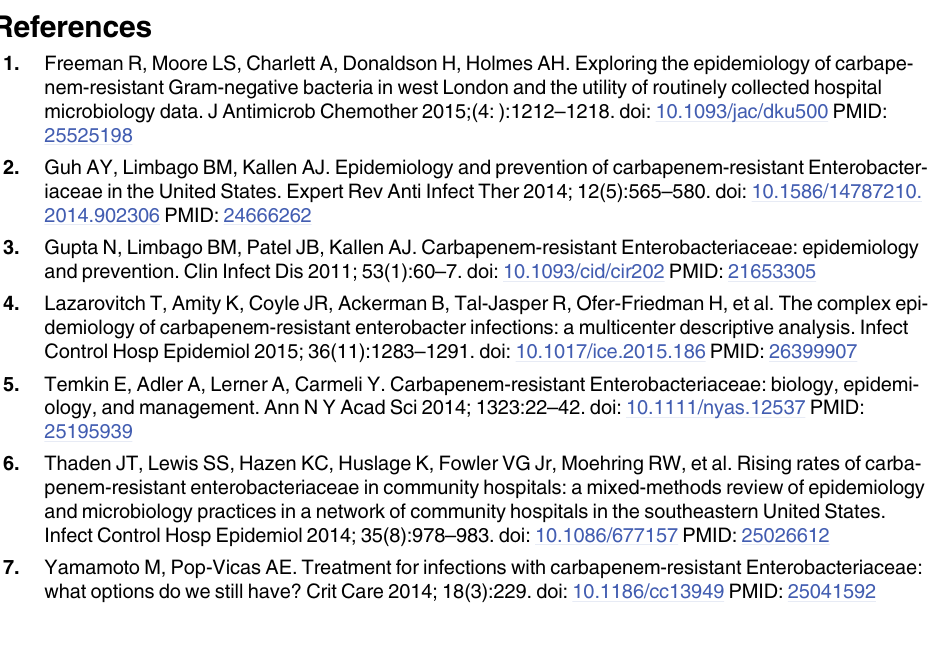
S1 Table. Clinical characteristics of the study